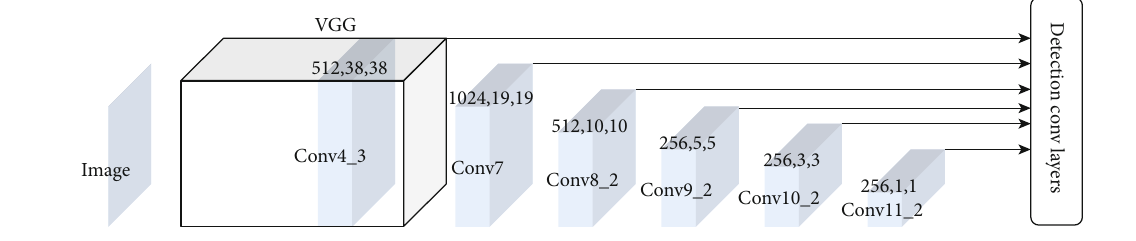
Figure 1: Original SSD architecture.